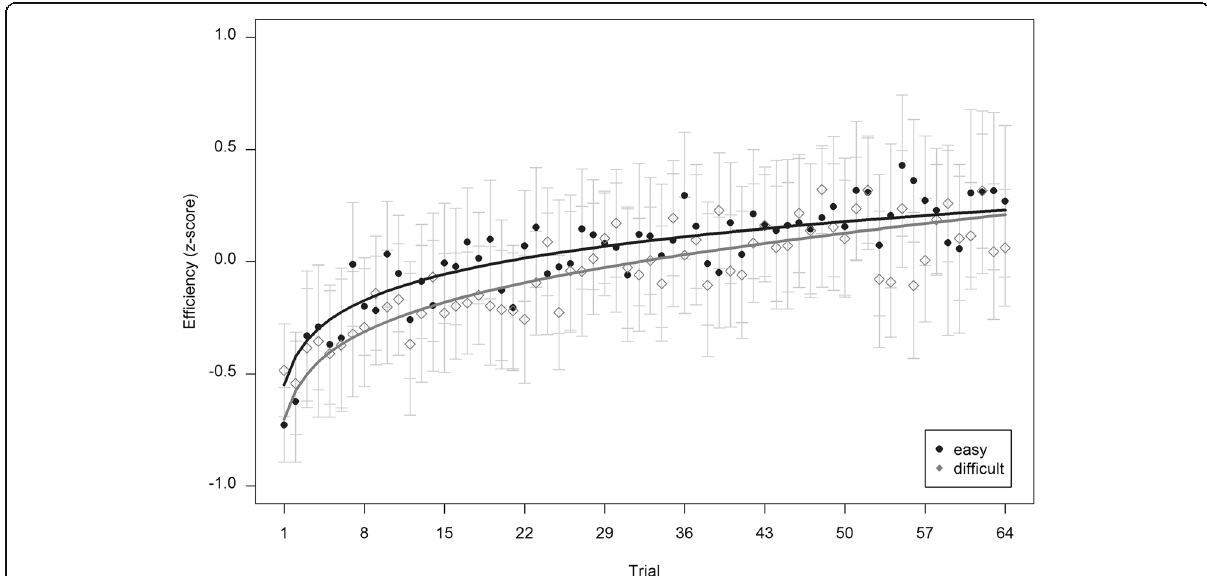
Fig. 5 Changes in performance in secondary task efficiency over the task. Filled dots and empty rhombi show empirical mean values per trial, lines indicate predicted mean values. Error bars indicate 95% confidence intervals from empirical